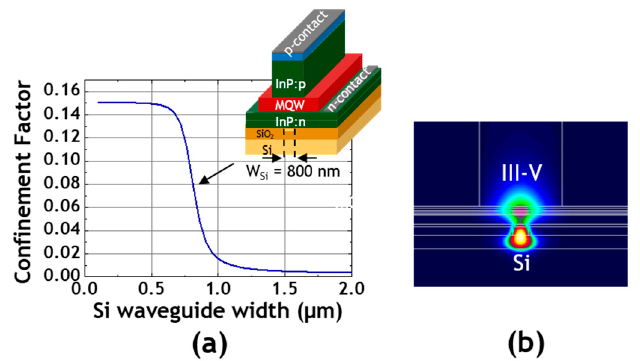
Figure 12. ( a ) Evolution of the optical confinement versus silicon waveguide width with Hybrid FP laser description on the top right; ( b ) optical mode simulation obtained for a 800 nm-wide silicon waveguide.